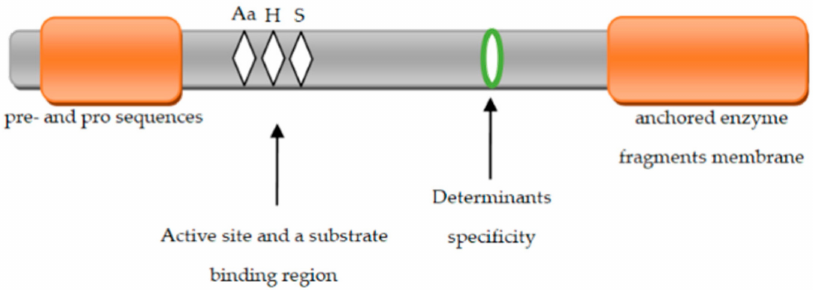
Figure 2. Functional regions in the structure of proteinases associated with the cell wall of LAB. Aa, H, S—location of the residues: aspartic acid, histidine, and serine forming the catalytic triad. The first domain occurring at the N-terminus of the enzyme molecule is a preprodome (PP) composed of a signal peptide containing 40 residues and a pro sequence containing 150 residues. The pro sequence section is removed by the autocatalysis process involving the PrtM protein located outside the cell membrane [23,67]. The PP domain is followed by a catalytic serine protease (PR) domain of 500 residues. It contains the active center of the enzyme and is formed by aspartic acid, histidine, and serine. Next, there is the insert domain (I) with 150 residues [4], which probably modulates the proteinase sub- strate specificity (CEP). Bruinenberg et al. [68] showed that the lack of domain I does not play such a significant role in the activity of extracellular enzymes; it does not occur in Lacticaseibacillus rhamnosus . The next domain is domain A (400 residues) with an